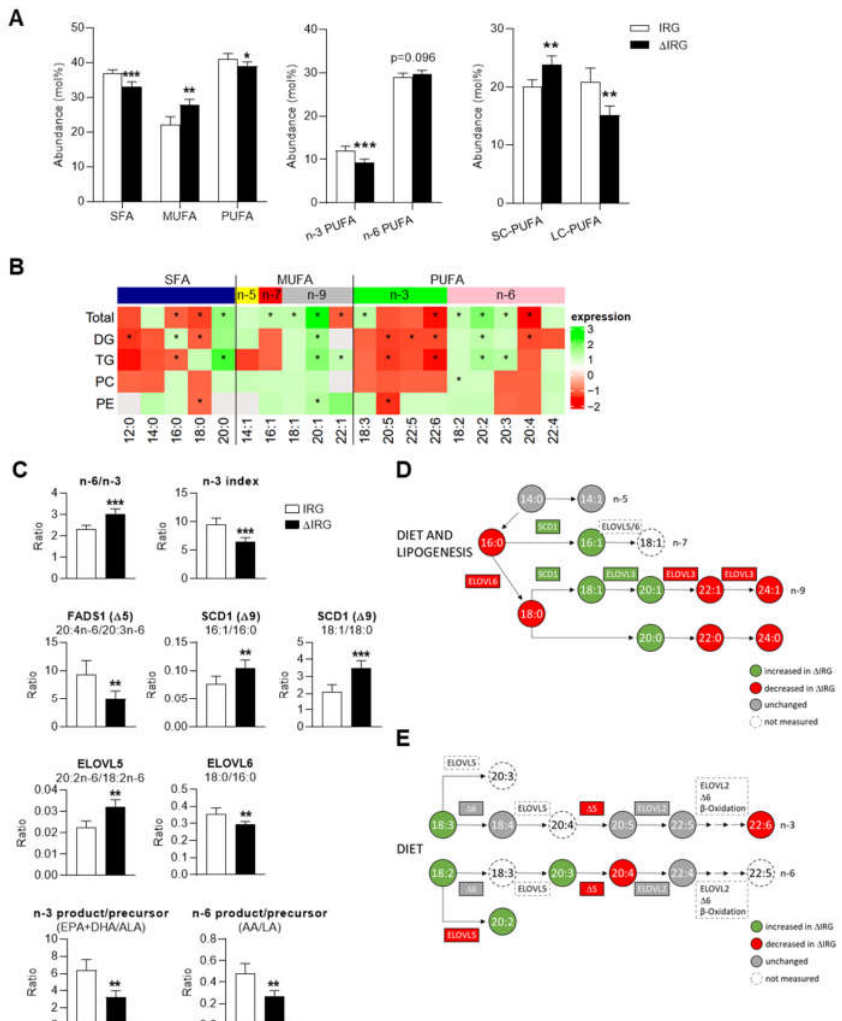
Figure 3. Impact of altered lipophagic capacity on fatty acid composition. ( A ) Relative quantity of saturated (SFAs), monounsaturated (MUFAs) and ployunsaturated (PUFAs) fatty acids levels ( left ). Abundance of n-3 and n-6 PUFAs ( middle ) and analysis of PUFAs in regard of chain length ( right ). ( B ) Heat map presenting the distribution of different fatty acid species within total fatty acids (top row) and individual lipid classes in ∆ IRG and compared to IRG mice. * indicates significant differences. Not detected fatty acids are marked in grey. ( C ) Evaluation of enzyme activities based on product to precursor ratios. The n-6/n-3 ratio includes the fraction of all fatty acids that belong to either the n-3 or the n-6 series. The n-3 index comprises all n-3 fatty acids. Schemes for the biosynthesis of ( D ) SFAs and MUFAs as well as ( E ) PUFAs. Visualization adapted from mapping tool Lipid Surveyor™ by Metabolon. Data are shown as means ± SD and analyzed by unpaired t -test with Welch’s correction. * p < 0.05; ** p < 0.01; *** p < 0.001; IRG, n = 7; ∆ IRG, n =